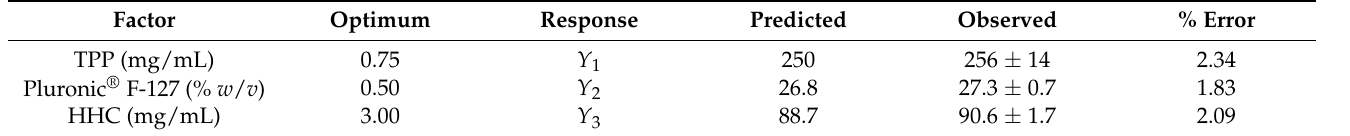
Table 3. Optimized composition of HHC-CS-NPs with predicted and experimentally observed